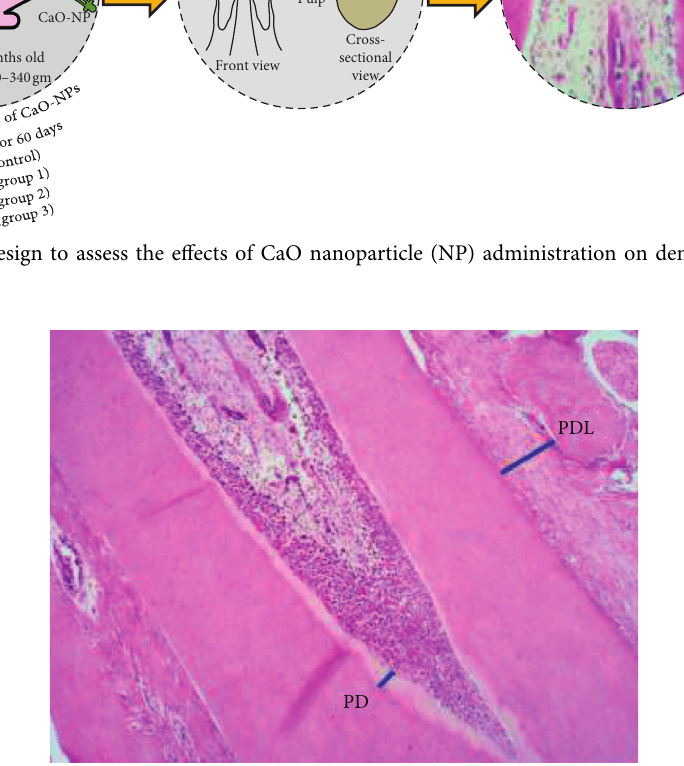
Figure 2: Analysis of the histological images by ImageJ software measuring thickness of the predentin (PD) and periodontal ligament